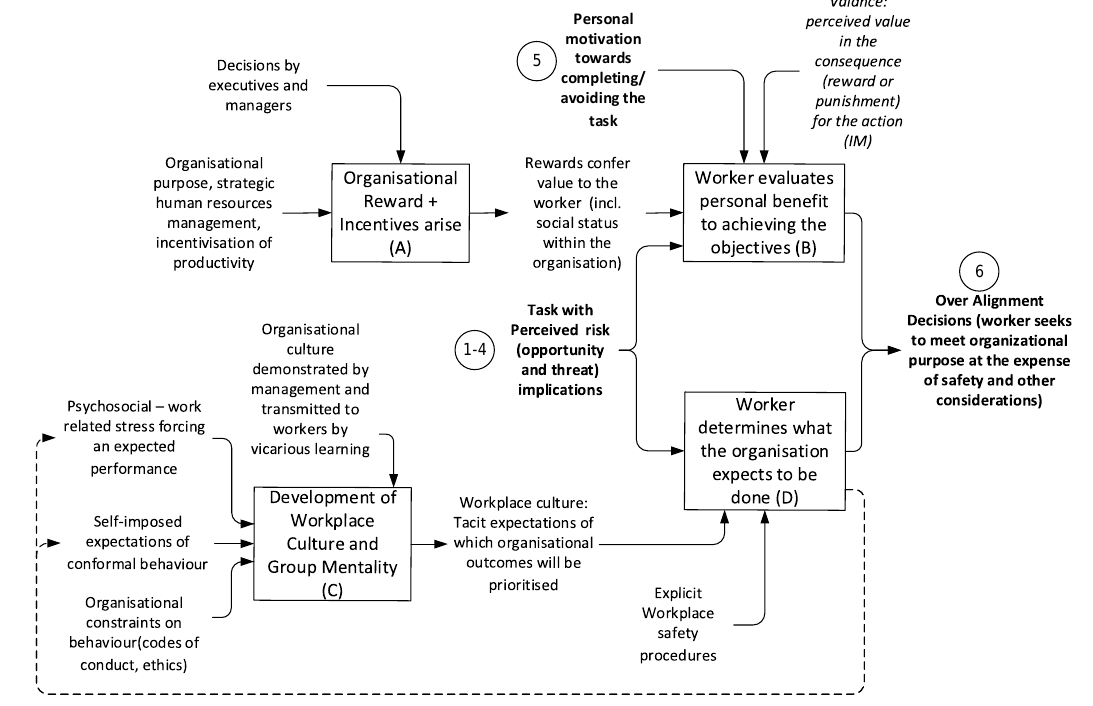
Figure 6. Extrinsic Motivation Model.